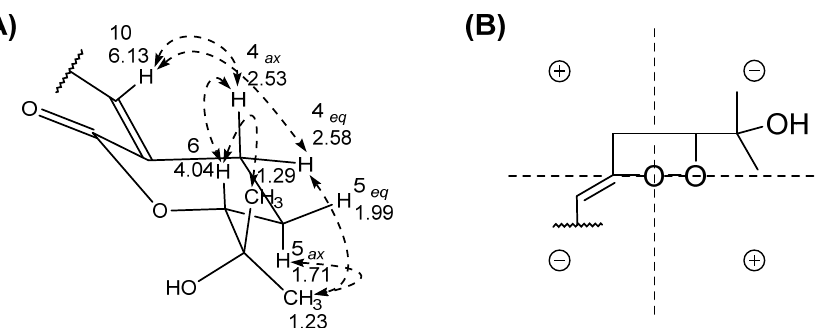
Figure 3. Key rotating frame overhauser enhancement spectroscopy correlations ( A ) and octant rule carbonyl projection ( B ) of compound 1 .